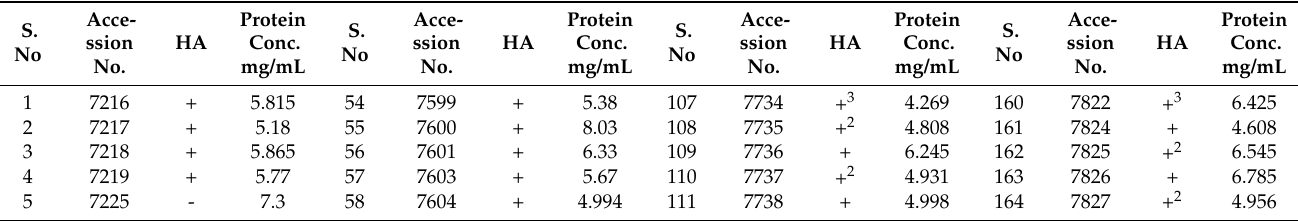
Table 3. Hemagglutination activity (HA) with Californian breed rabbit RBCs and protein content (mg/mL) in the seeds of rice ( Oryza sativa L.) accessions using Bradford